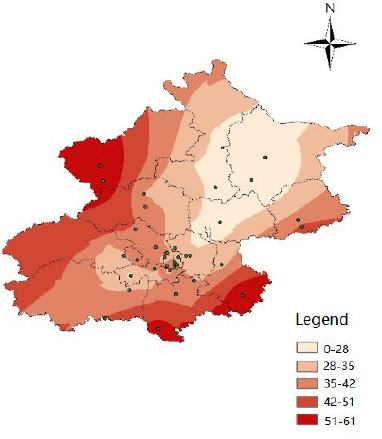
Figure 4. Predicted distribution of average PM2.5 concentration in 2020 January 1.